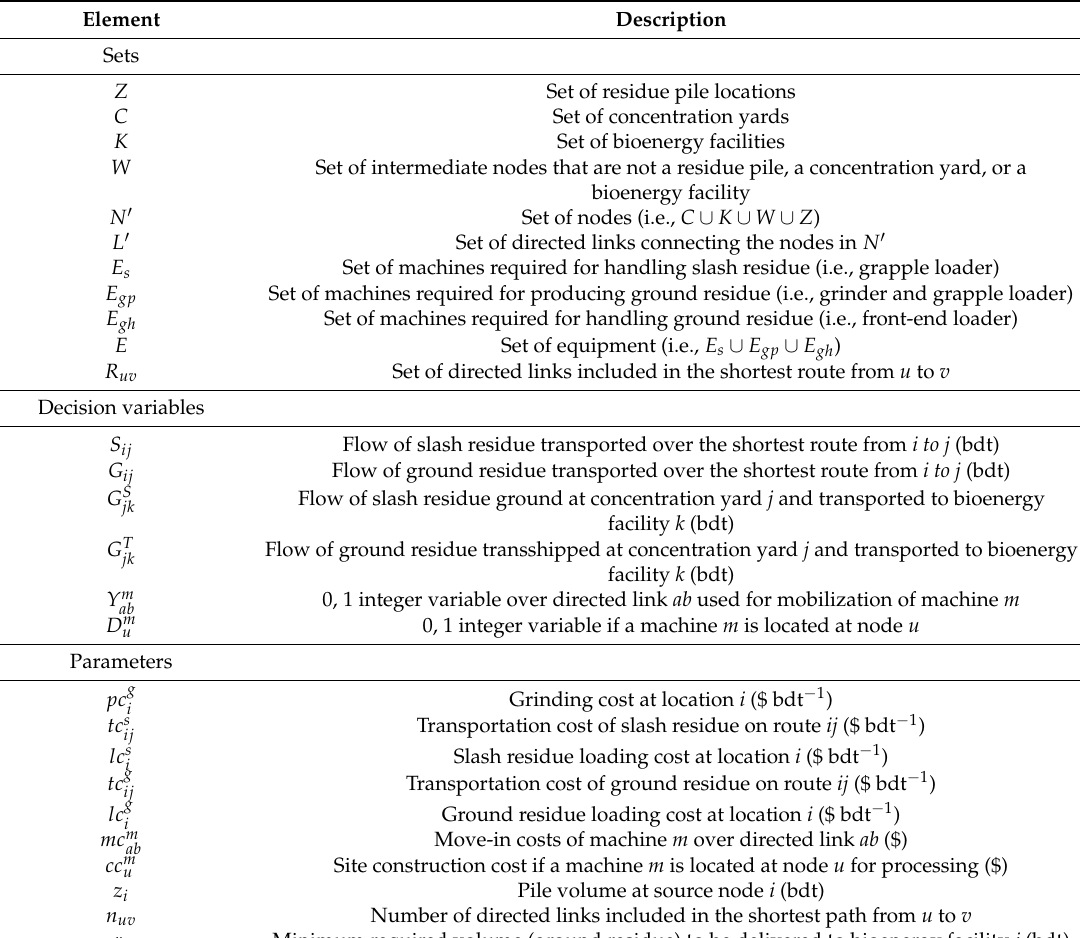
Table 1. Sets, decision variables, and parameters of the optimization